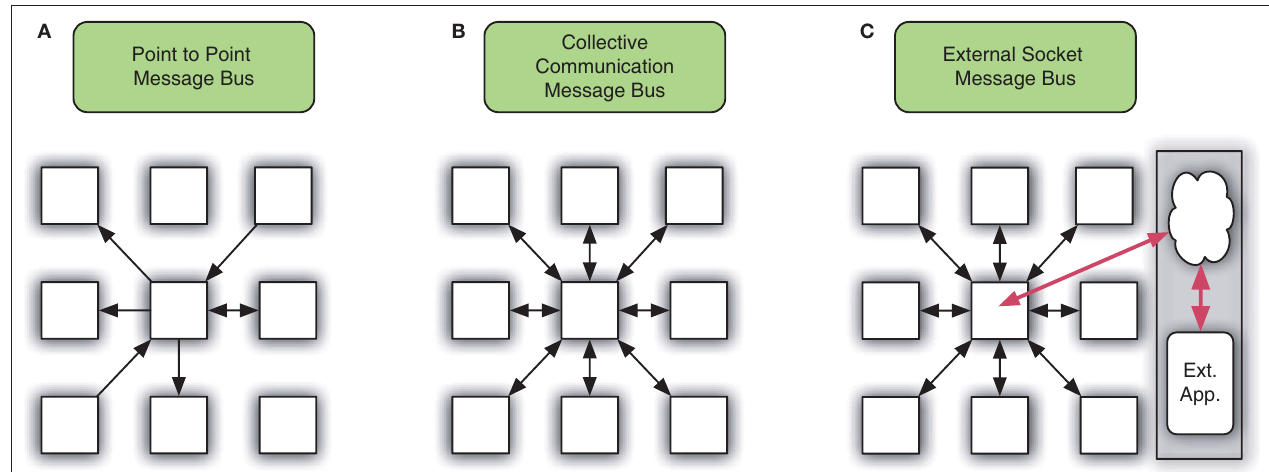
FIGURE 3 | Three possible implementations of the Message Bus. Each square represents a Node for computation, arrows indicate delivery of AP messages. (A) Point–Point communications using MPI_Send and MPI_Recv. (B) Collective Communication using MPI_AllGather. (C) Extension to B featuring external socket